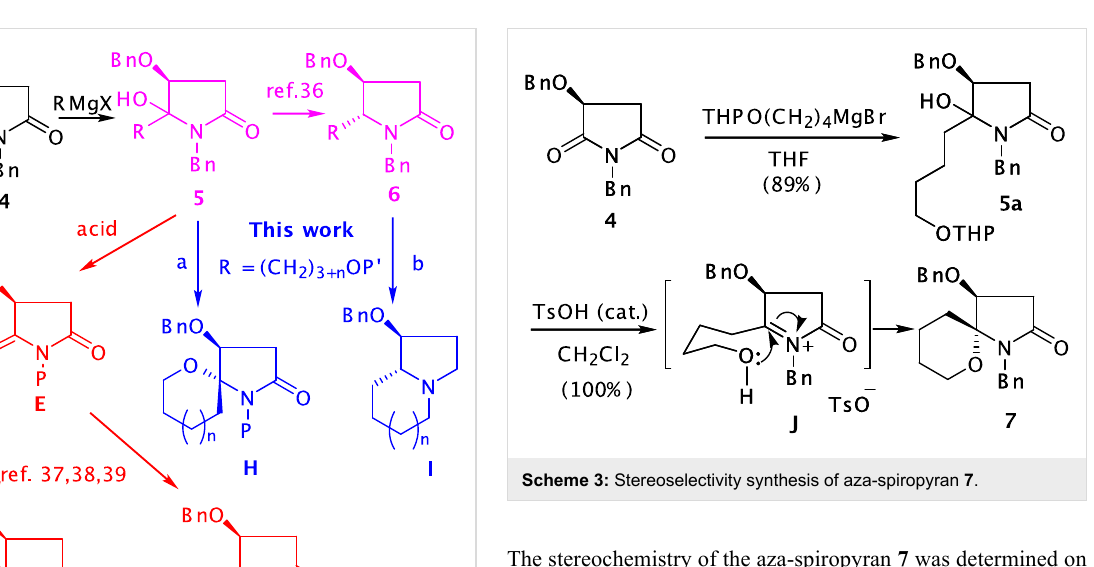
according to the 1 H NMR